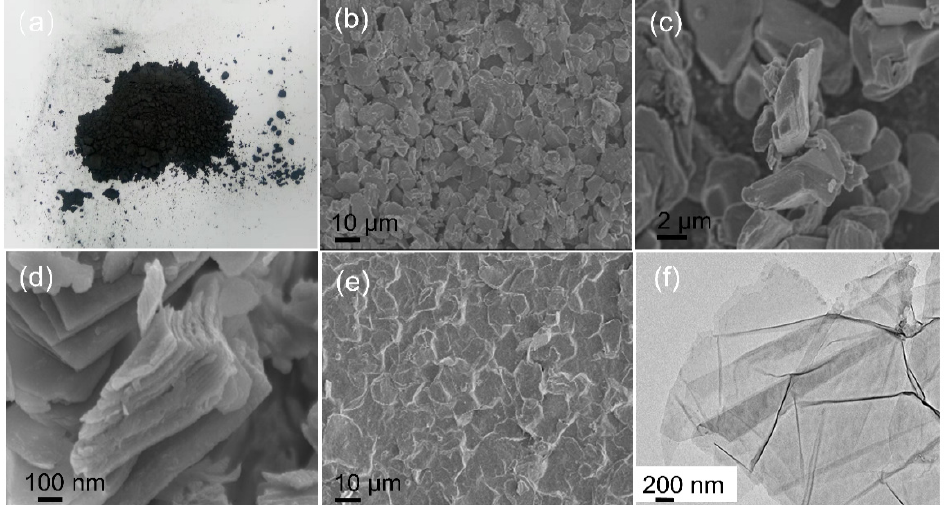
Figure 2. ( a ) Image of Ti 3 AlC 2 (MAX). ( b , c ) SEM images of MAX. ( d ) SEM images of multi-layer MXene (Ti 3 C 2 T x ) and ( e ) vacuum-filtered MXene. ( f ) HRTEM images of MXene.